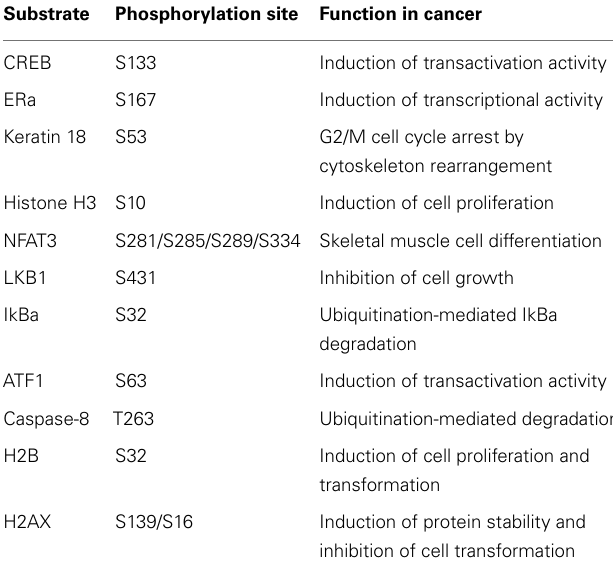
Table 3 | RSK2 substrates and cellular function in cell proliferation and